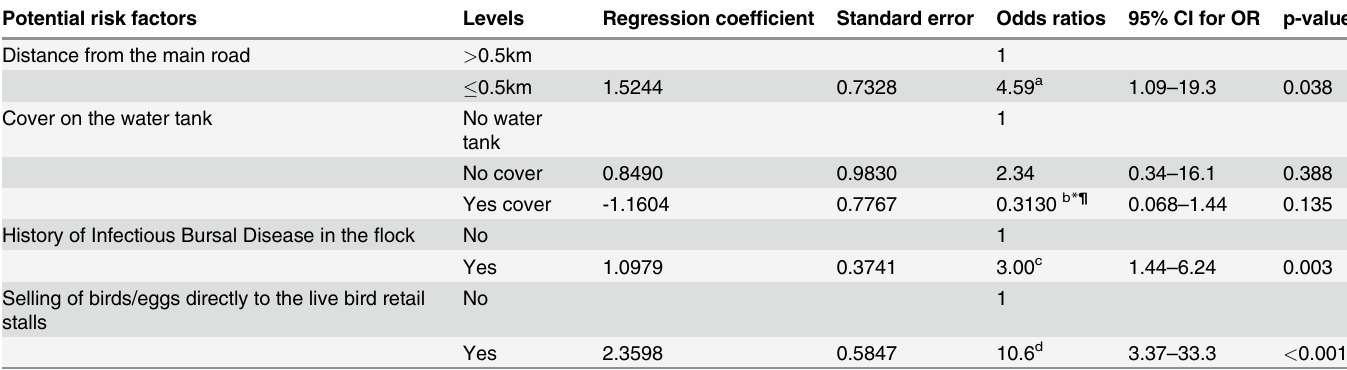
Table 3. Model 2 — Risk factors associated with Avian In fl uenza type H9N2 infection on commercial poultry farms in Pakistan based on a backward manual stepwise selection process on all variables available in Table 1 except distance to the nearest case farm. Potential risk factors